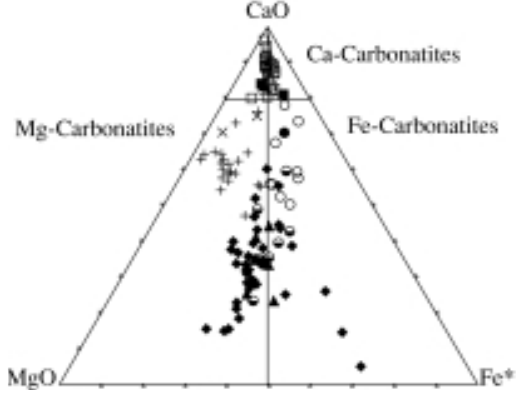
Fig. 5 – Composition of carbonatites and mica-rich rocks from Araxá plotted on the Woolley and Kempe’s (1989) CaO-MgO- Fe*(Fe*=FeO+Fe 2 O 3 +MnO)diagram(wt%). Symbols: empty square, CaC; full square, CaC, Ph; vertical cross, MgC; inclined cross, MgC, Ph; empty circle, FeC; full circle, FeC, Ph; full dia-